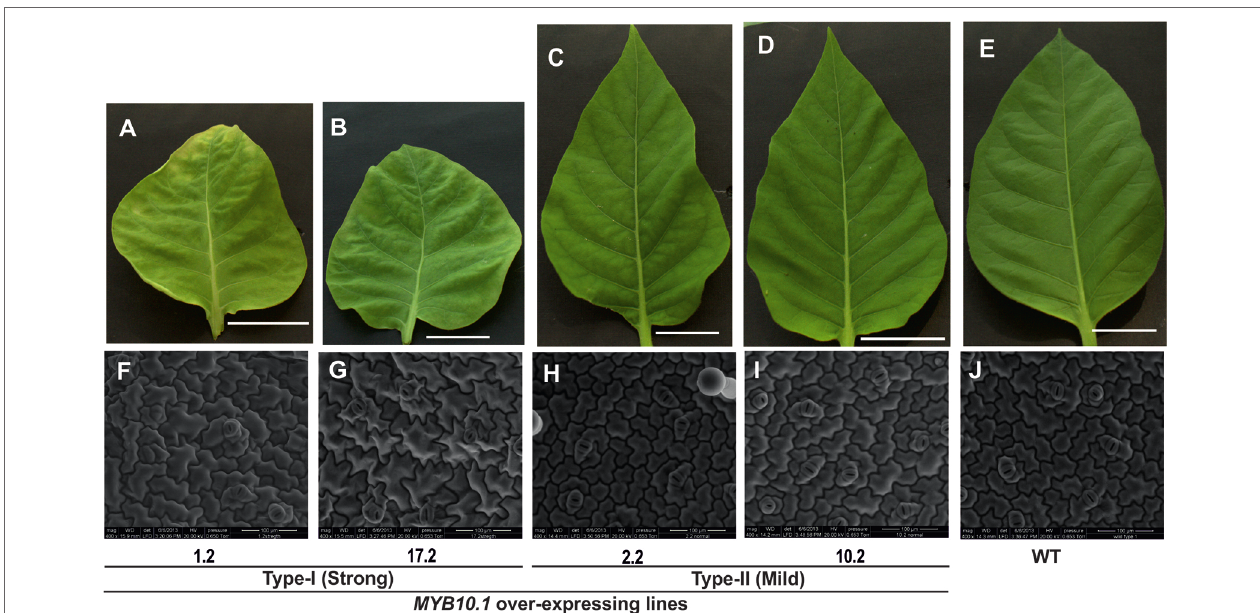
FIGURE 2 | Phenotypic analysis of the upper leaf surface of the transgenic tobacco lines compared to WT. Photographs (A – E) of leaves with the same age and internode for both transgenic and WT plants. Size bars stand for 5 cm. The images (F – J) of the upper surfaces of leaves were taken by means of an environmental scanning electron microscope (ESEM). Size bars stand for 100 µm.